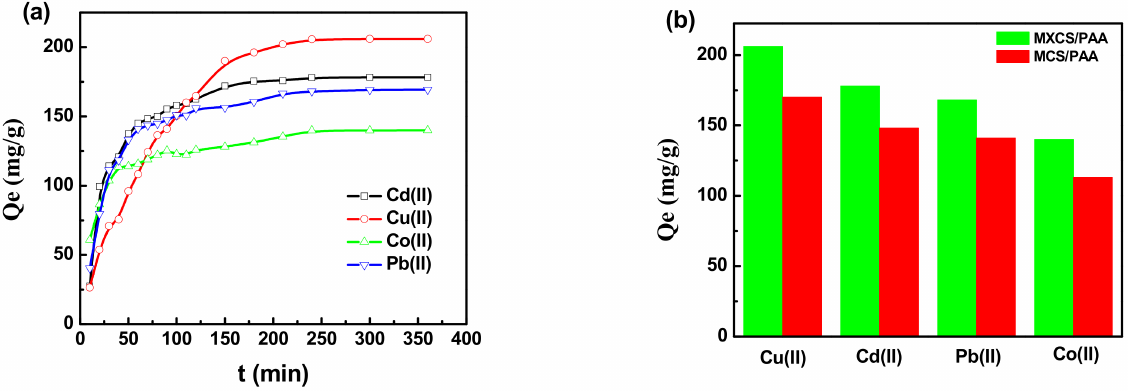
Figure 5. ( a ) Effect of contact time on the adsorption capacity of MXCS/PAA hydrogels at 303 K and 1 g/L, ( b ) adsorption performance of MXCS/PAA and MCS/PAA under optimal